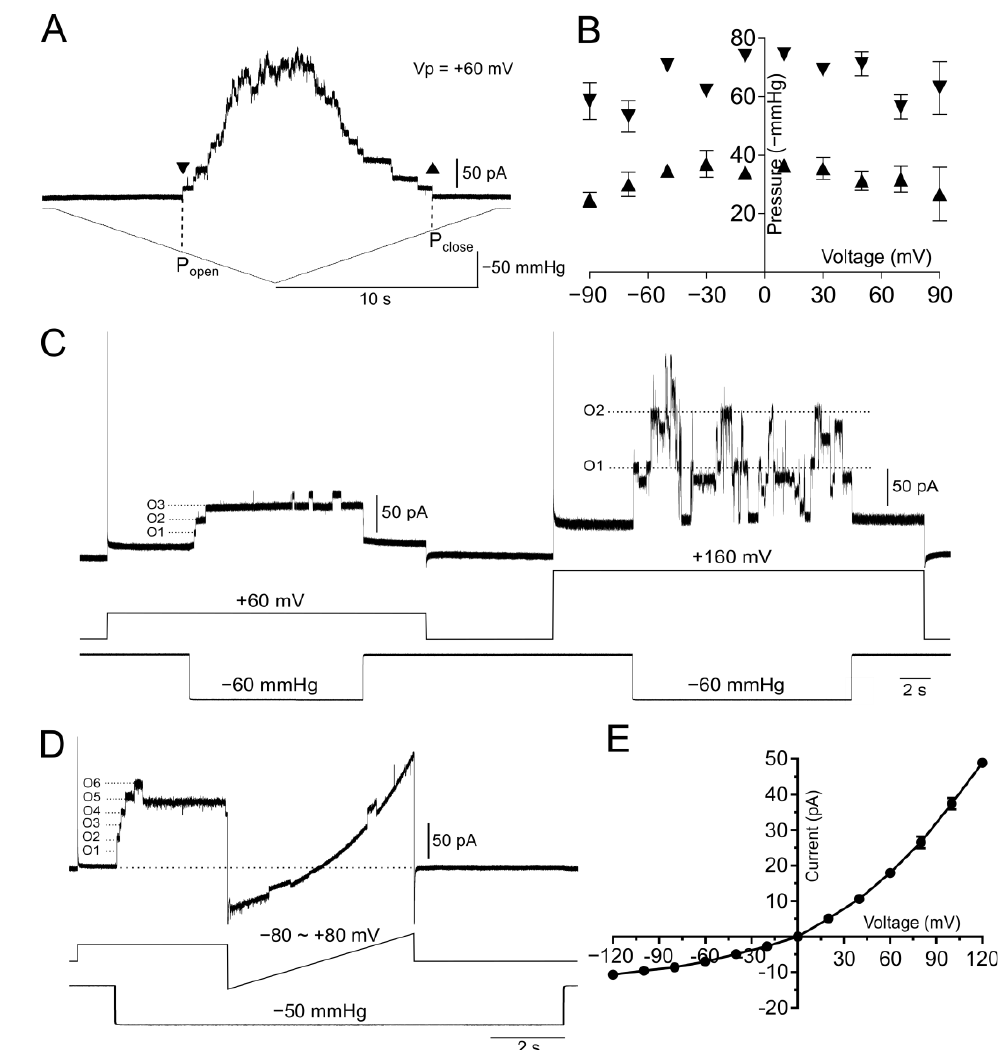
Figure 3. Electrophysiological characterization of the purified MscCG protein reconstituted into liposomes. ( A ) Gating hysteresis of the purified MscCG channels. Triangles show the first opening P open (downward) and the last closing P close (upward) of MscCG channels. ( B ) Voltage dependency of the first opening P open (downward triangles) and the last closing P close (upward triangles). Data were obtained from four independent patches. ( C ) Stable opening of three channels (O1-3) at +60 mV and subconducting states of two open channels (O1-2) at +160 mV under − 60 mmHg step. ( D ) Stable opening of channels (O1-6) under − 50 mmHg step and current rectification following a voltage ramp from − 80 mV to +80 mV. ( E ) Single channel conductance I – V curve of the purified MscCG channels ( n = 4 – 11). Bars show standard deviation.